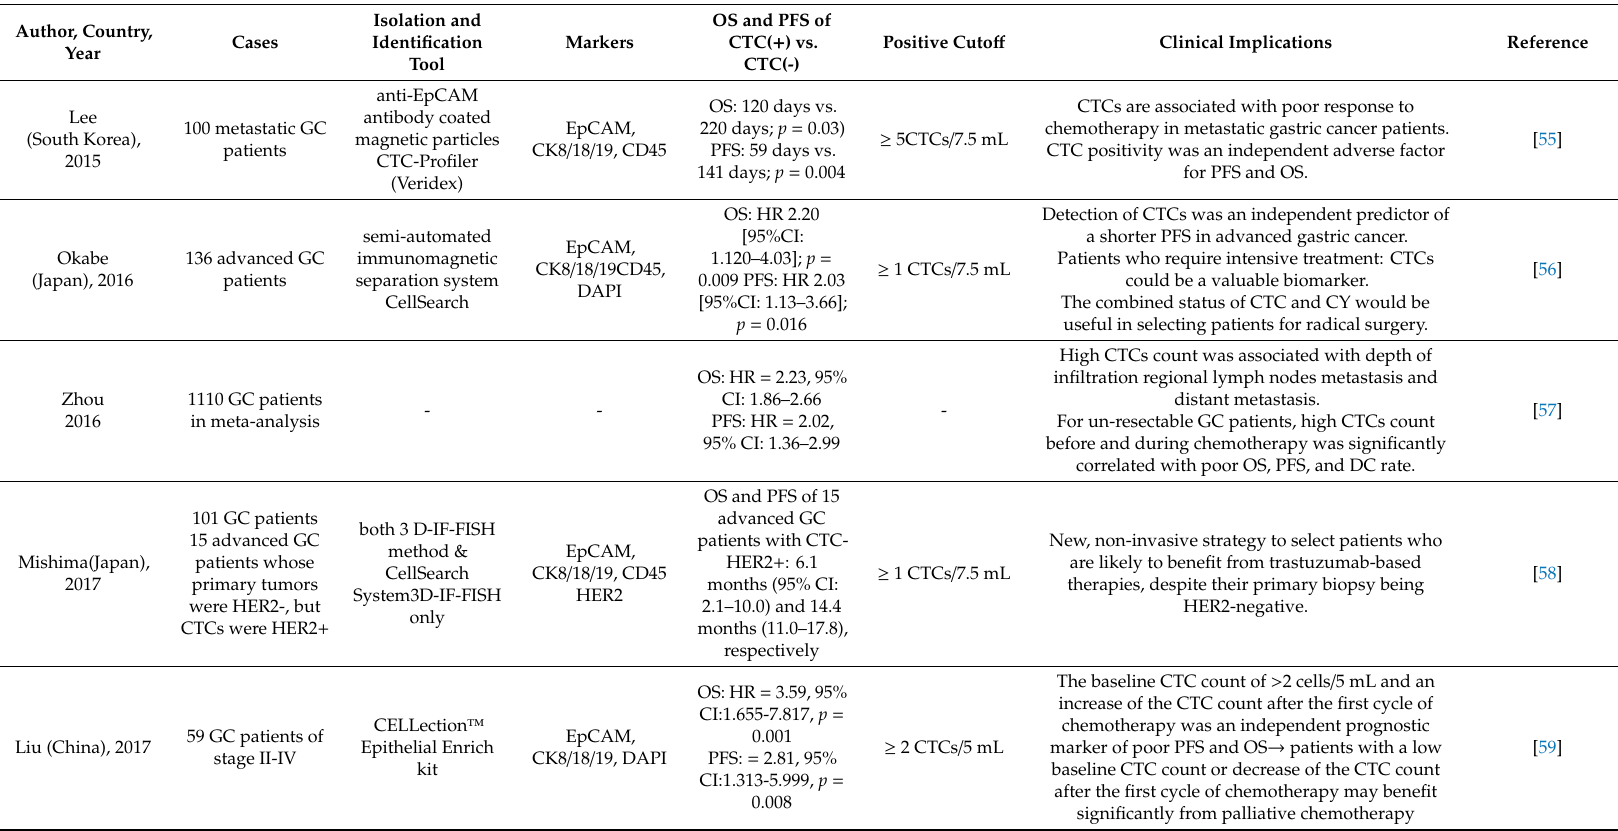
Table 1. Systematic Review of the Clinical Significances of Circulating Tumor Cells (CTCs) in Gastric Cancer (GC) in Studies during 2015–2019